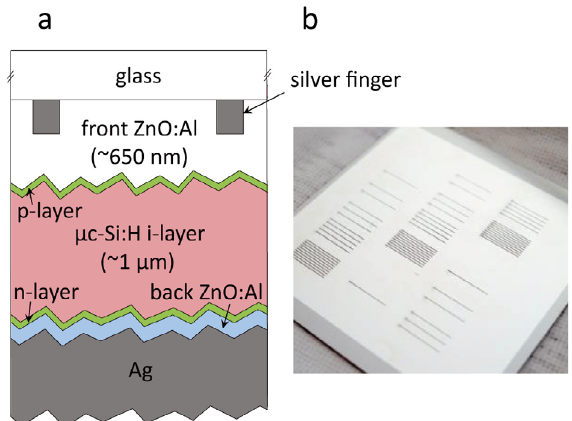
Fig. 1. (a) Schematic cross section of a µ c-Si:H p-i-n solar cell deposited on a highly transparent front TCO layer with Ag fingers. (b) Evaporation mask employed to deposit the Ag fingers on the glass superstrate. The line width is varied be- tween 100 µ m and 200 µ